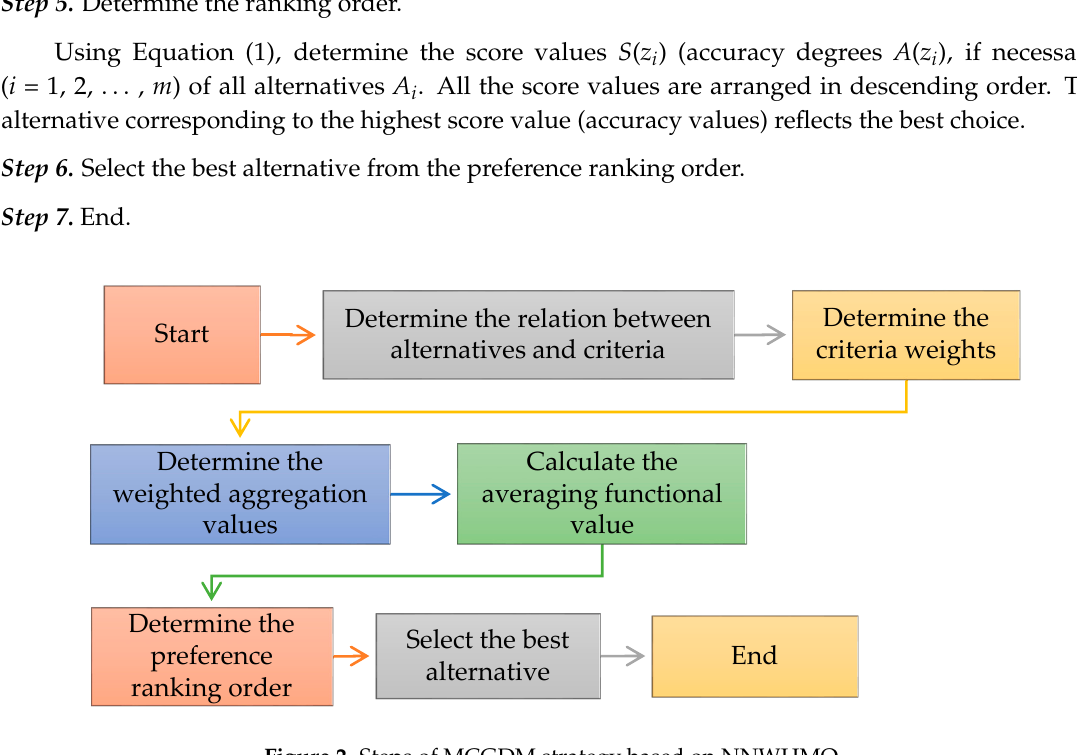
Figure 2. Steps of MCGDM strategy based on NNWHMO.